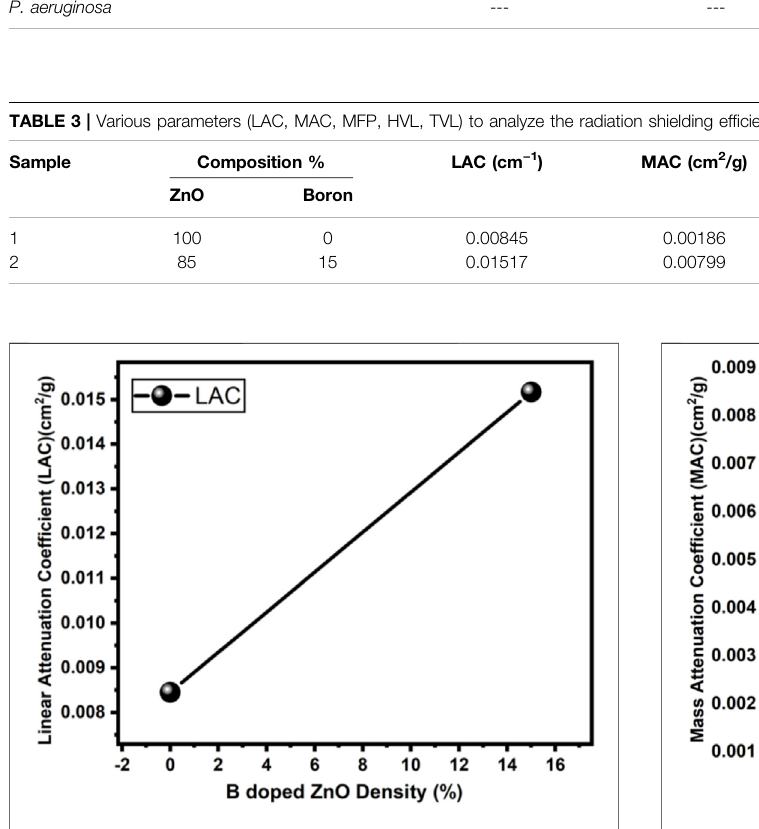
(Khalid et al., 2021b)